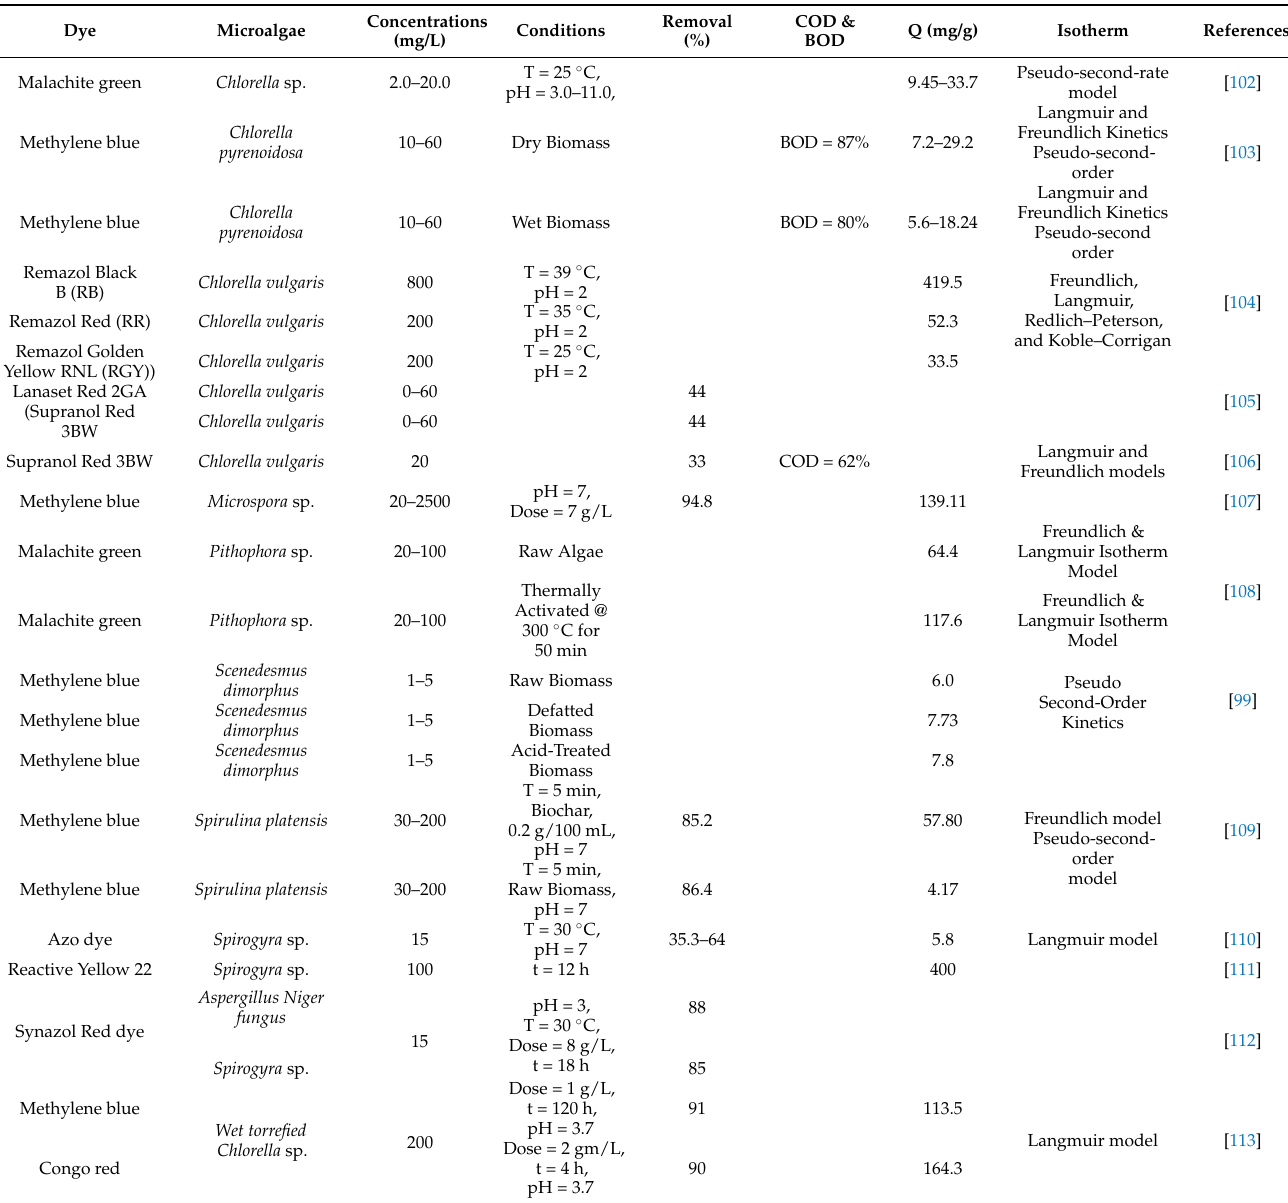
Table 5. Dye eradication from textile wastewater using